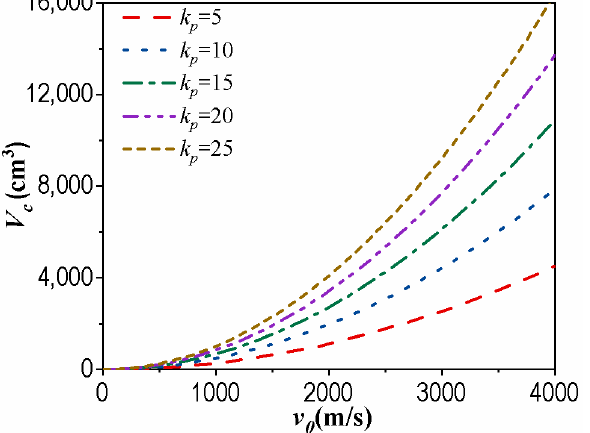
ff erent k p values under the same projectile